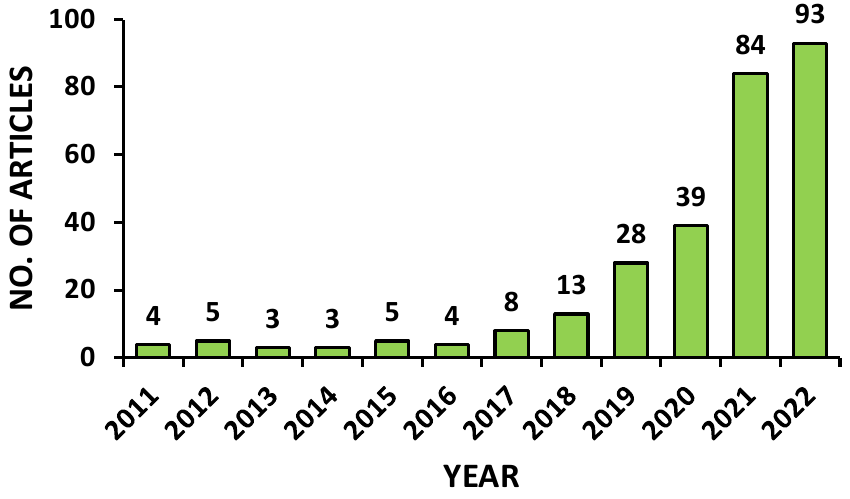
Figure 2. Year-wise (January 2011 to October 2022 distribution of retrieved articles.